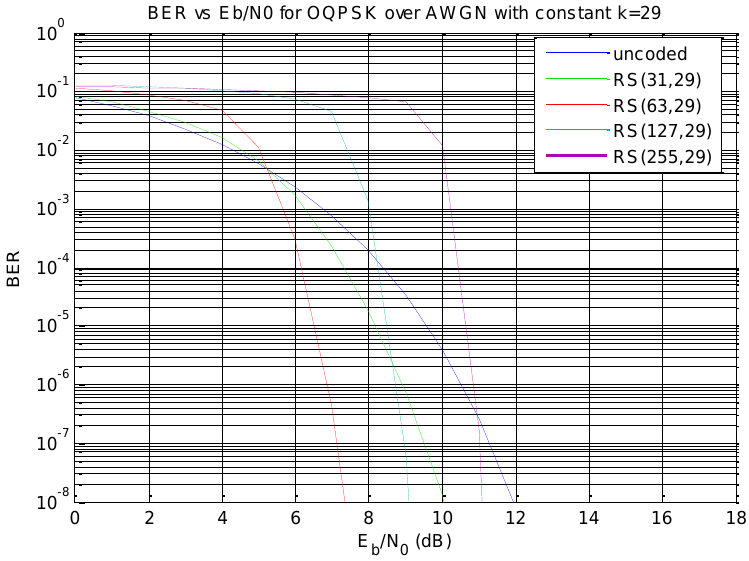
Figure 10. RS error performance for OQPSK over AWGN channel with constant k , increasing n –